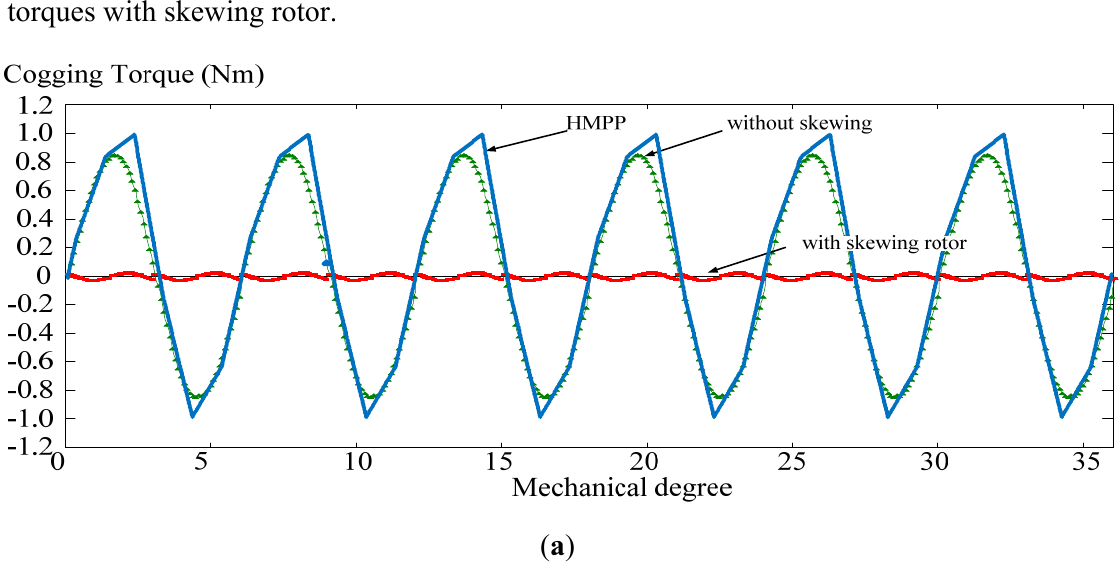
Figure 6. Cogging torque experienced in 1/10 revolution: ( a ) comparison between full model and HMPP; ( b ) two-segment rotor structure; ( c ) component and resultant cogging torques with skewing